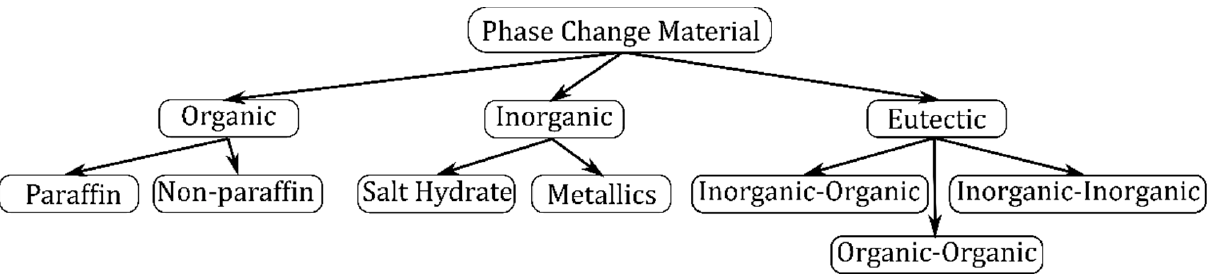
Figure 6. Classification of PCMs. These criteria must be fulfilled for optimal selection of a PCM material for